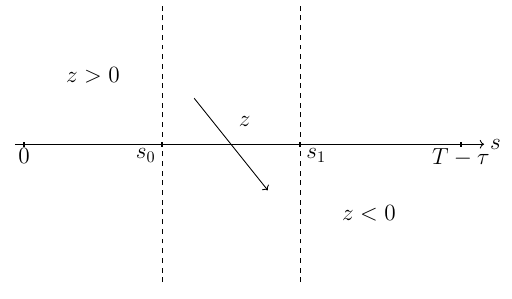
Figure 12. Behaviour of z ( t ) when σ f = σ m